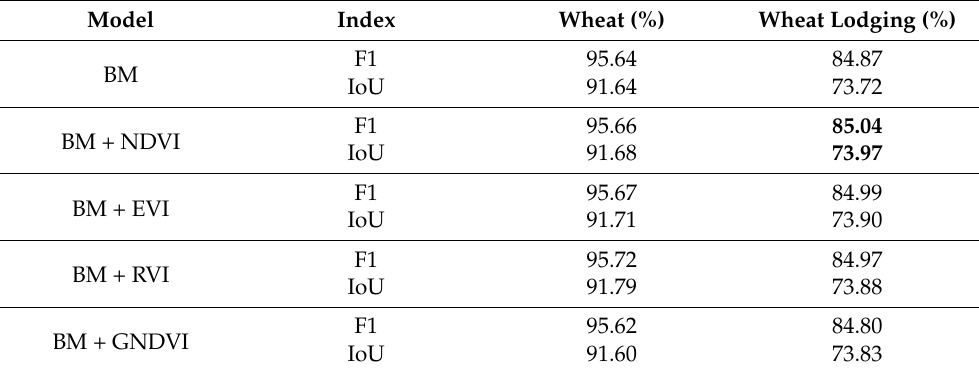
Table 4. Segmentation results comparison of using different VIs on the test dataset.